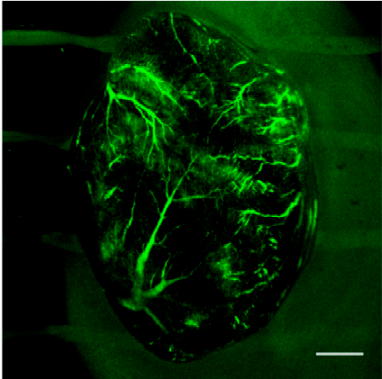
Figure 11. Ex vivo cartography of cardiac blood vasculature. Intravenous injection of fluorescein isothiocyanate (FITC)-dextran was performed in anaesthetized animals (for experimental procedures, please see [183]). After ligating, the heart was removed and directly placed on the stage of a confocal macroscope for imaging. FITC-dextran labeled blood circulation. Scale bar: 1 mm.